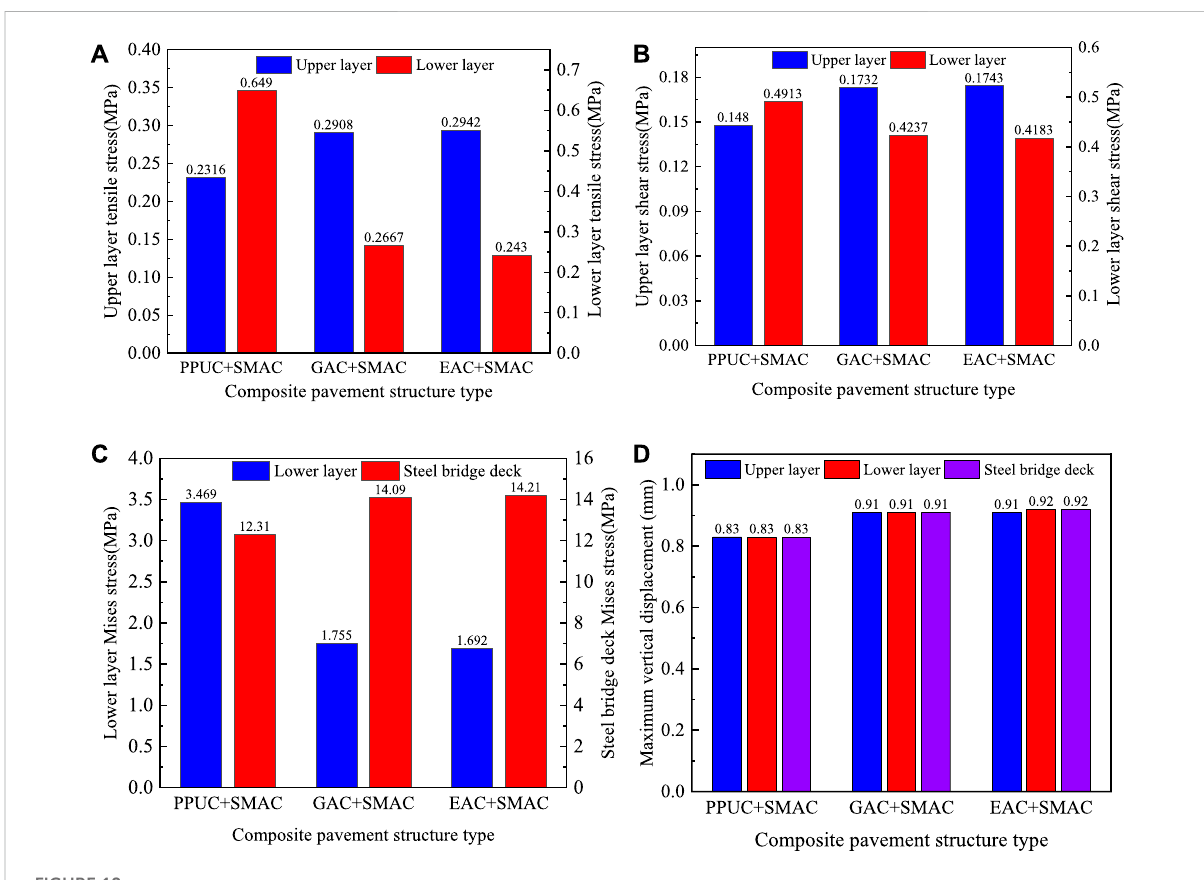
FIGURE 18 Comparison results of different composite pavement structures. (A) Maximum transverse tensile stress of the pavement; (B) Maximum shear stressofthepavement; (C) Misesstressofthelowerlayerandsteelbridgedeck; (D) Maximumverticaldisplacementofthepavementandsteelbridge